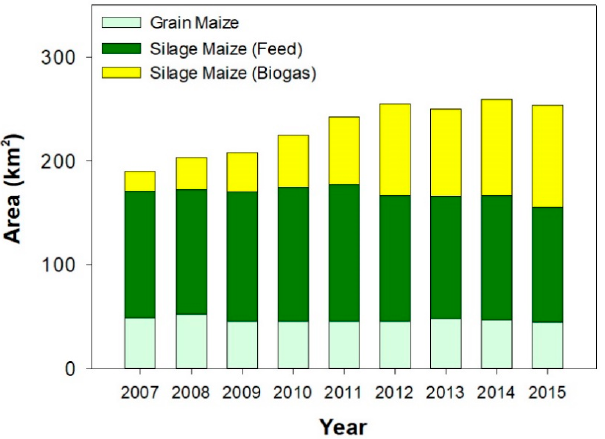
Figure 7. Germany silage maize cultivated area for different utilization purposes. Source: FNR.